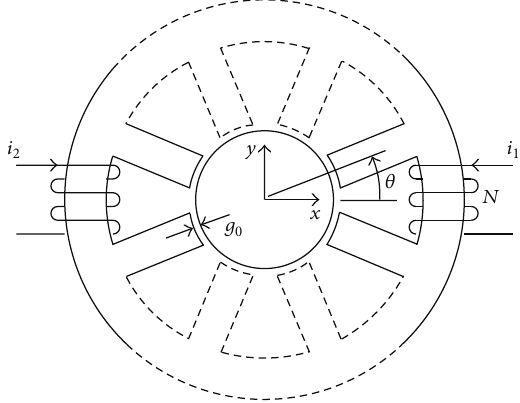
Figure 1: Eight-pole radial magnetic